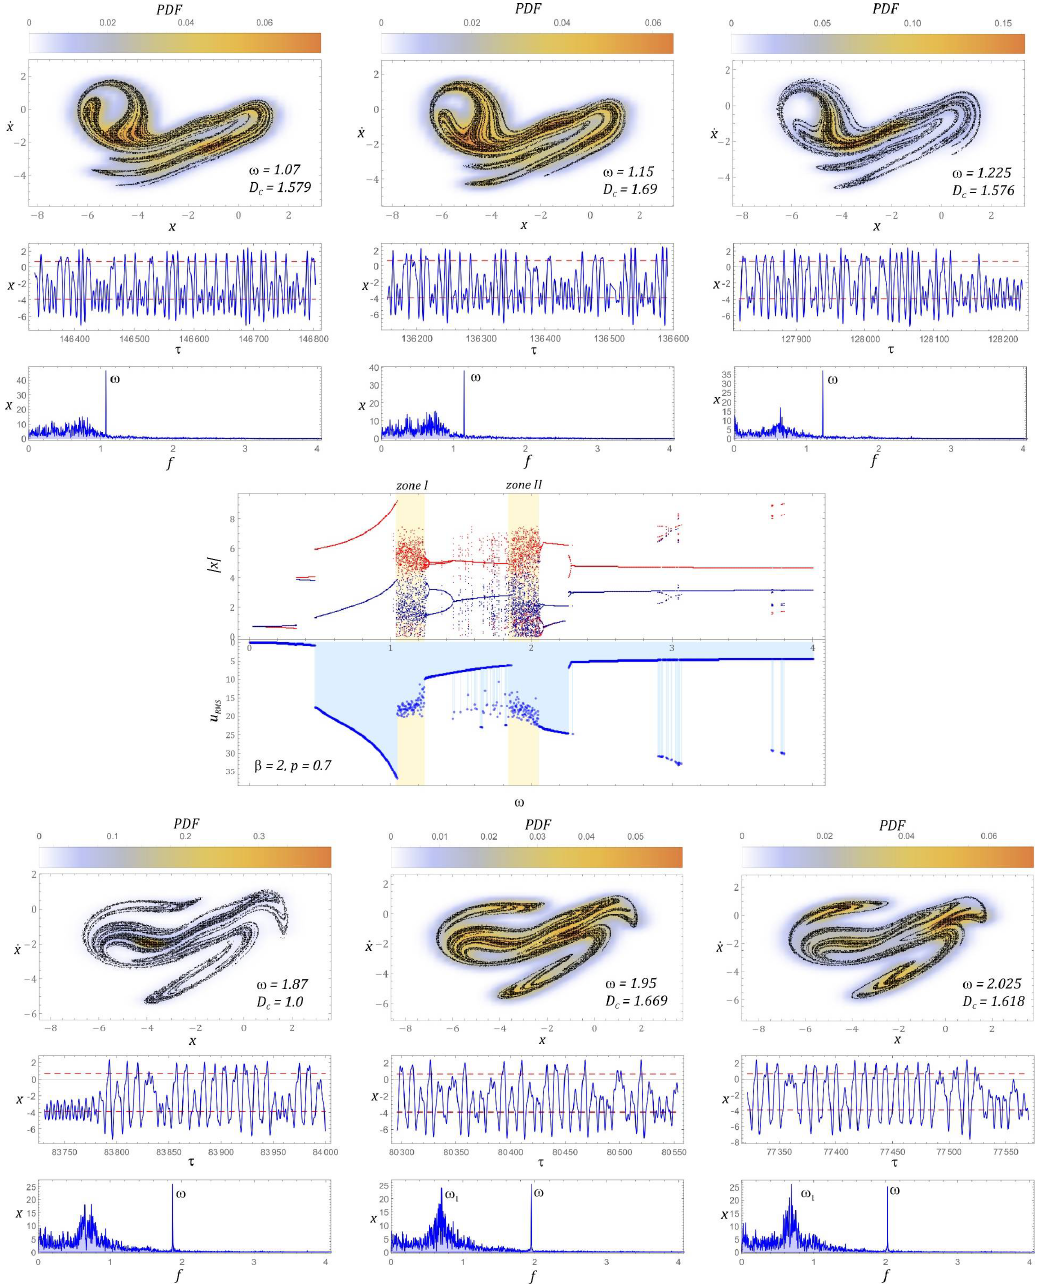
Figure 9. Bifurcation diagram correlated by the frequency footer with the diagram of RMS voltage induced on piezoelectric electrodes and examples of chaotic responses (Poincaré maps with correlation dimension and probability density function (PDF) indicated).